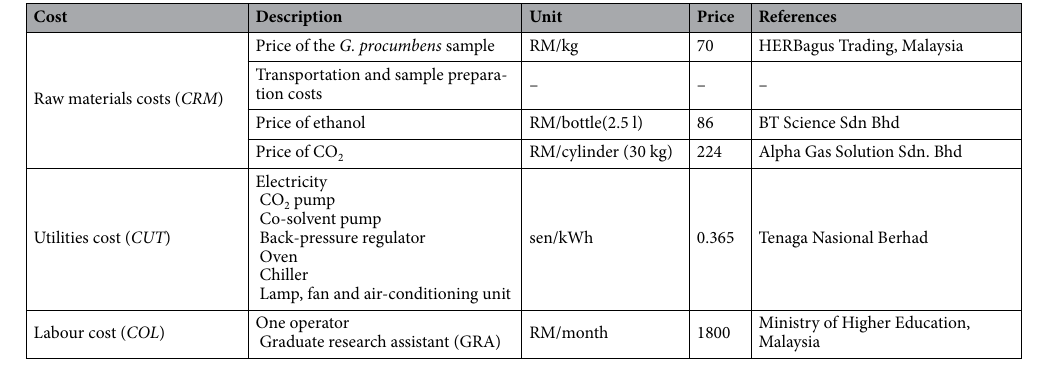
Table 4. The description of each category in direct